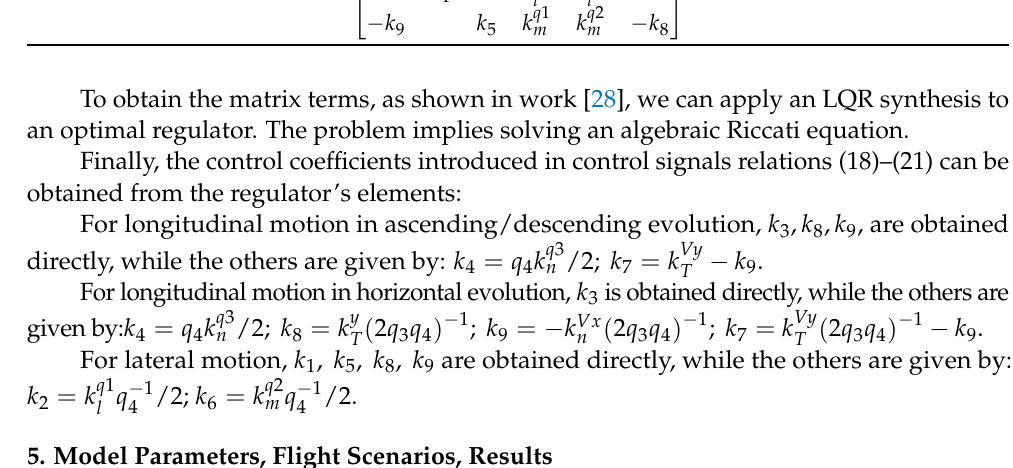
Table 11. The regulator matrix for lateral motion K .